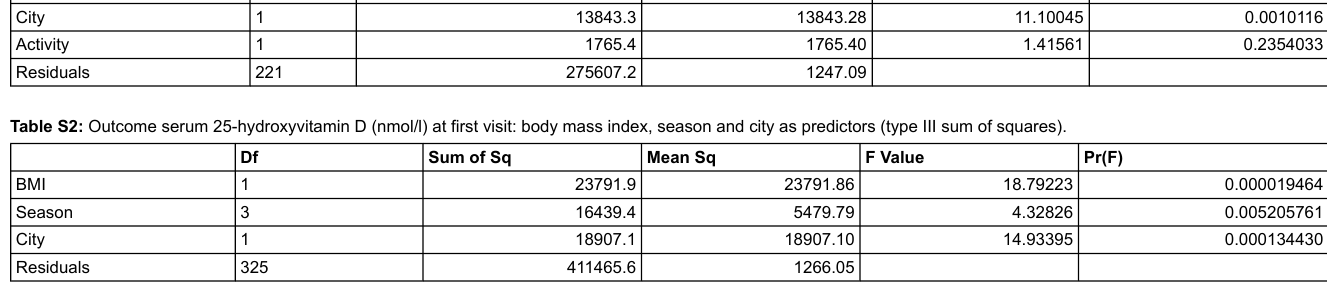
Table S3: Outcome serum 1,25-dihydroxyvitamin D (pg/ml) at first visit: all predictors (type III sum of squares).